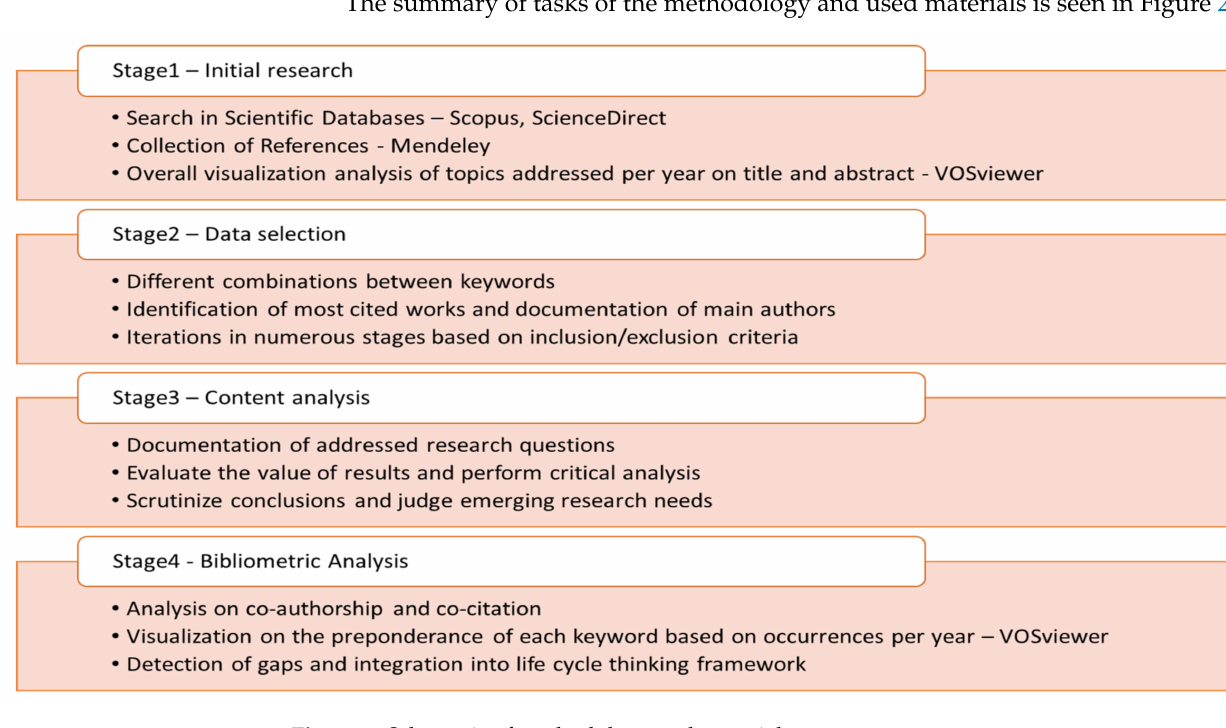
Figure 2. Schematic of methodology and